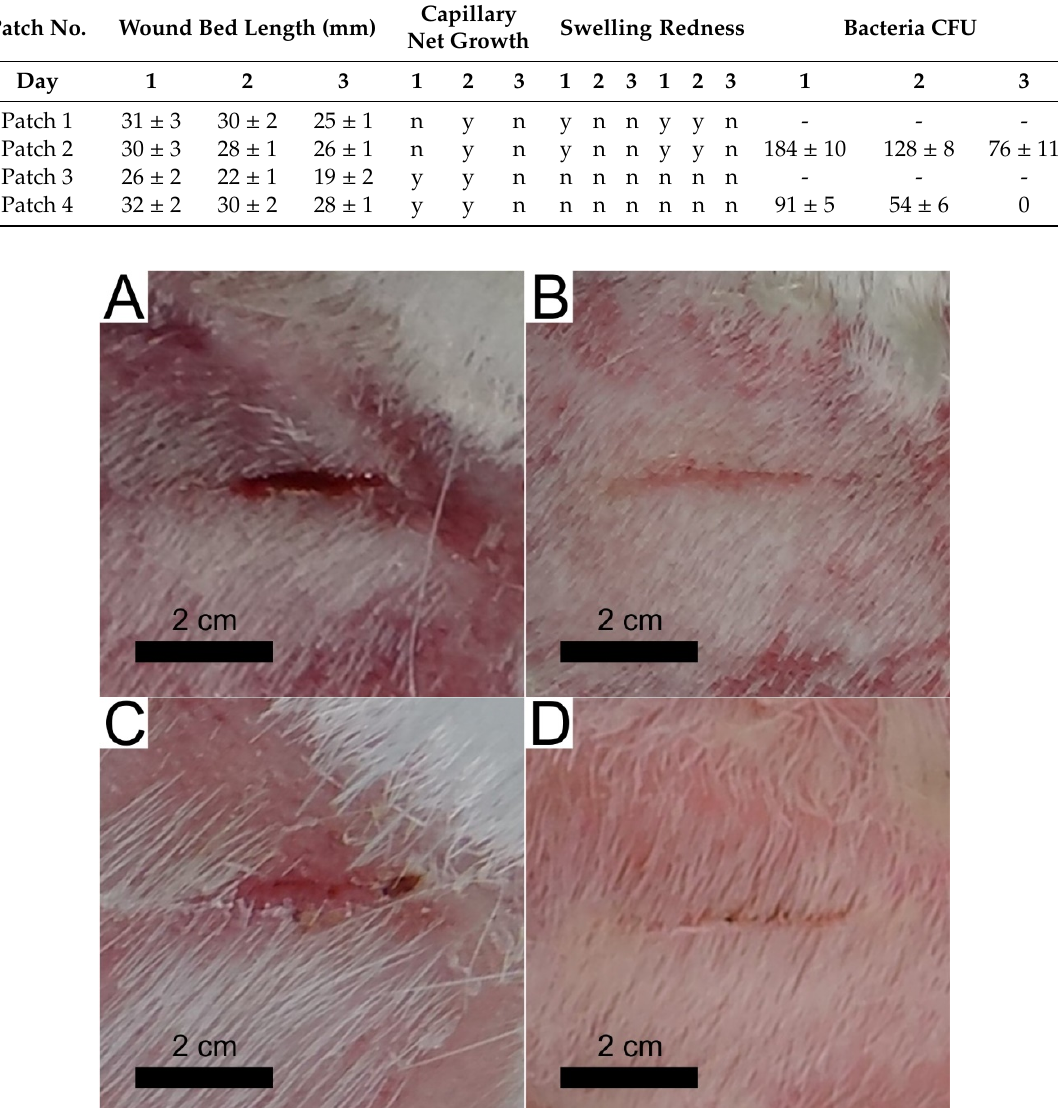
Figure 6. Camera images of the Guinea pig MRSA-infected wound treatment with the control patch ( A , B ) and proposed path ( C , D ) after 2 days ( A , C ) and 4 days ( B , D ) of